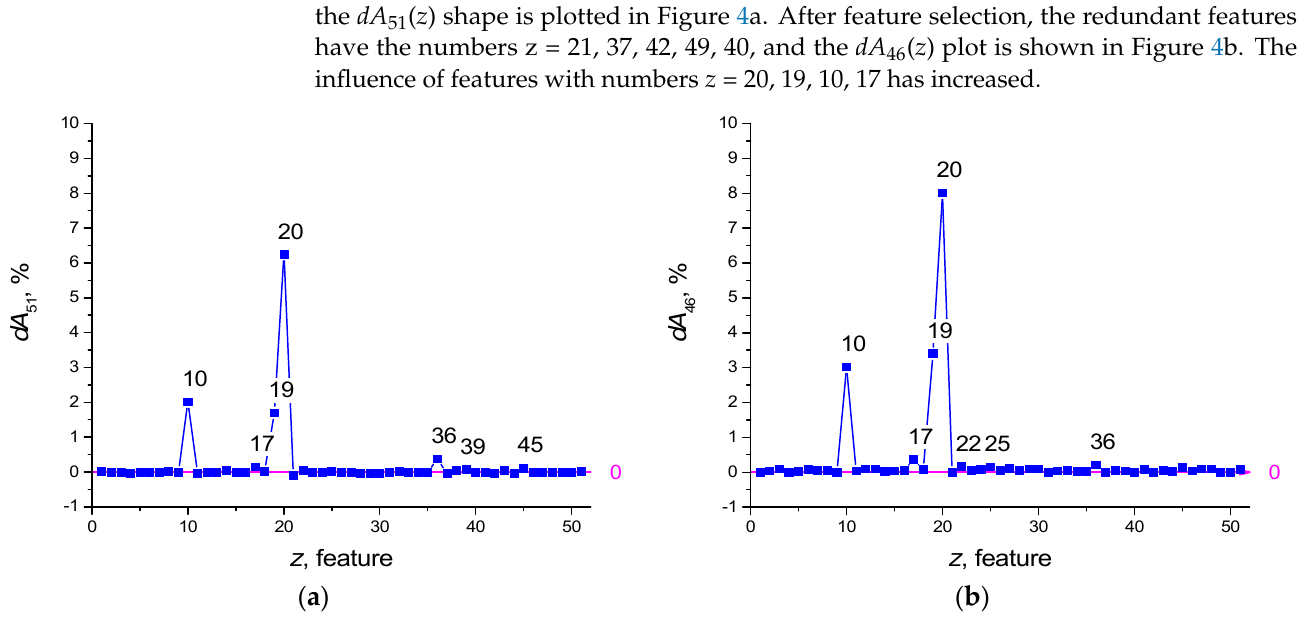
Figure 5. Dependence of A 46 ( FR [21,37,40,42,49]) on the number of epochs Ep .